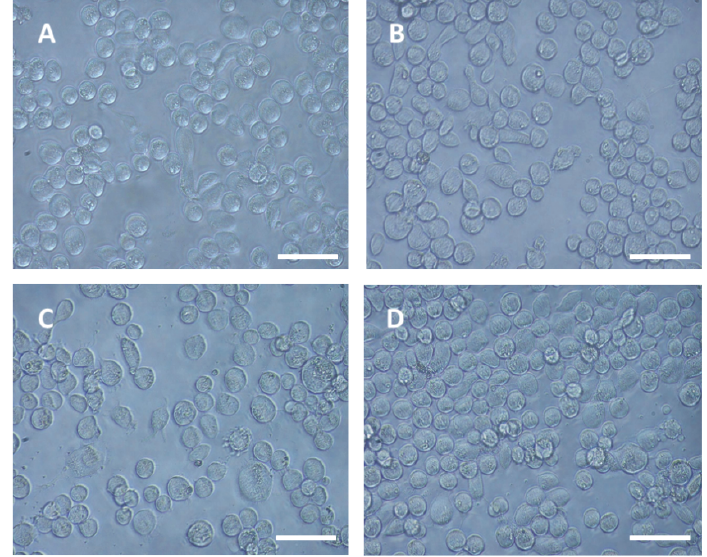
Figure 1. Light micrograph of Deformed wing virus (DWV)-infected and mock-infected P1 cells. DWV-infected cells at 0, 24, and 48h post-infection (panels A , B , and C , respectively); D , mock-infected cells at 48 h. Bar 50 µm.